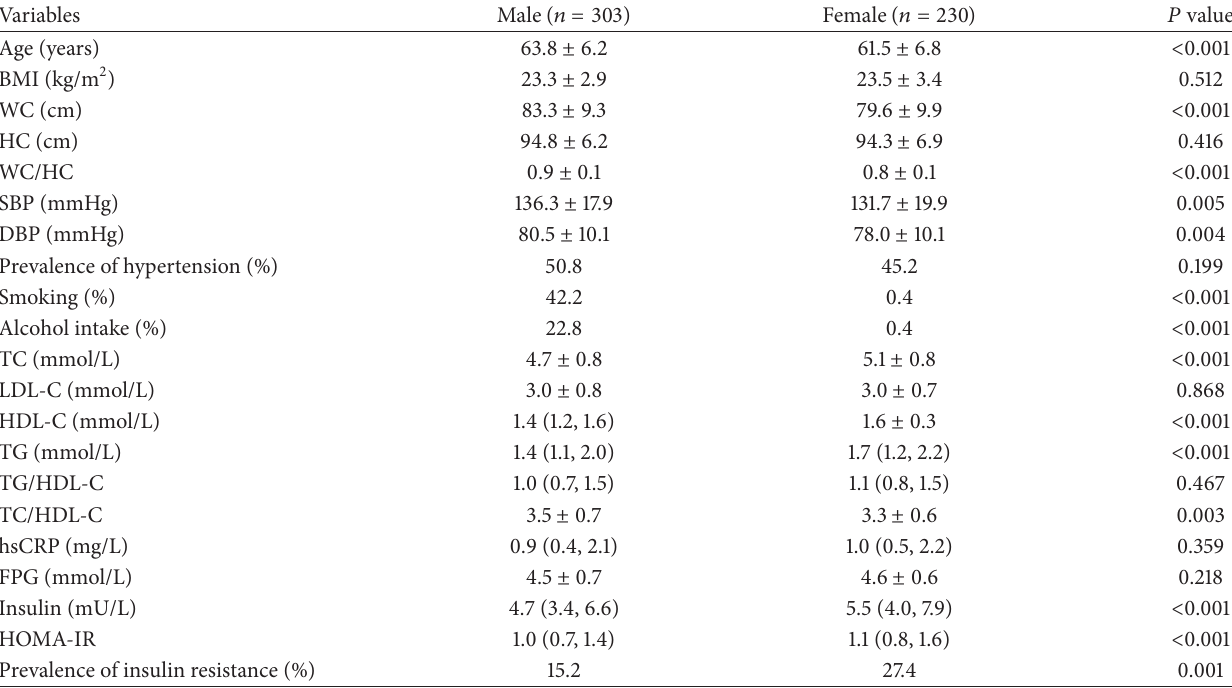
Table 1: Characteristics of the individuals.